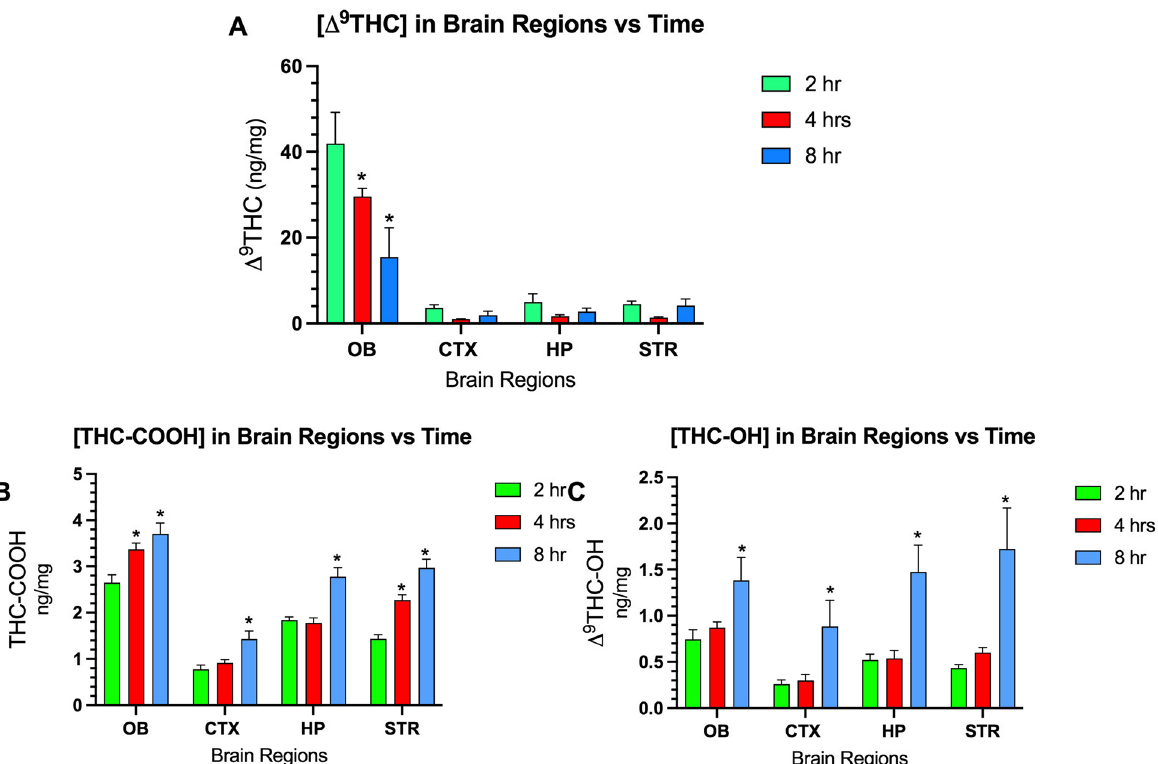
Fig. 3 A Changes over time of concentrations of Δ 9 THC (ng/mg) in four brain regions following intranasal instillation. Abbreviations: olfactory bulb (OB), cerebral cortex (CTX), hippocampus (HP), and striatum (STR). B Changes over time of THC‑COOH and C Δ 9 THC‑OH. Two‑way ANOVA analysis (brain regions vs time) was statistically significant for each set of data Δ 9 THC, THC‑OH, and THC that the brain region accounted for the greatest percentage of the total variance in levels of Δ 9 THC, THC‑COOH, and THC‑OH. N cohort euthanized at 2 and 4 h; N 6 for the 8‑h cohort. Dunnett’s multiple comparison reveals significant differences comparing levels at 4 and 8 h = compared to levels at 2 h (* p < =